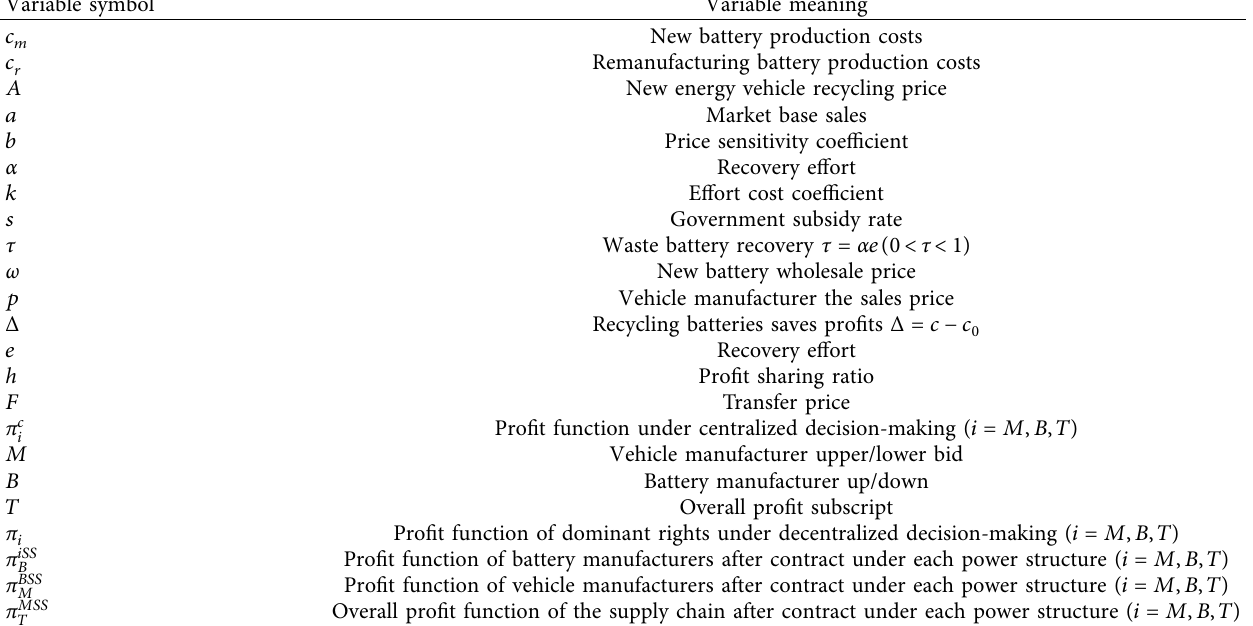
Table 1: Variables and their